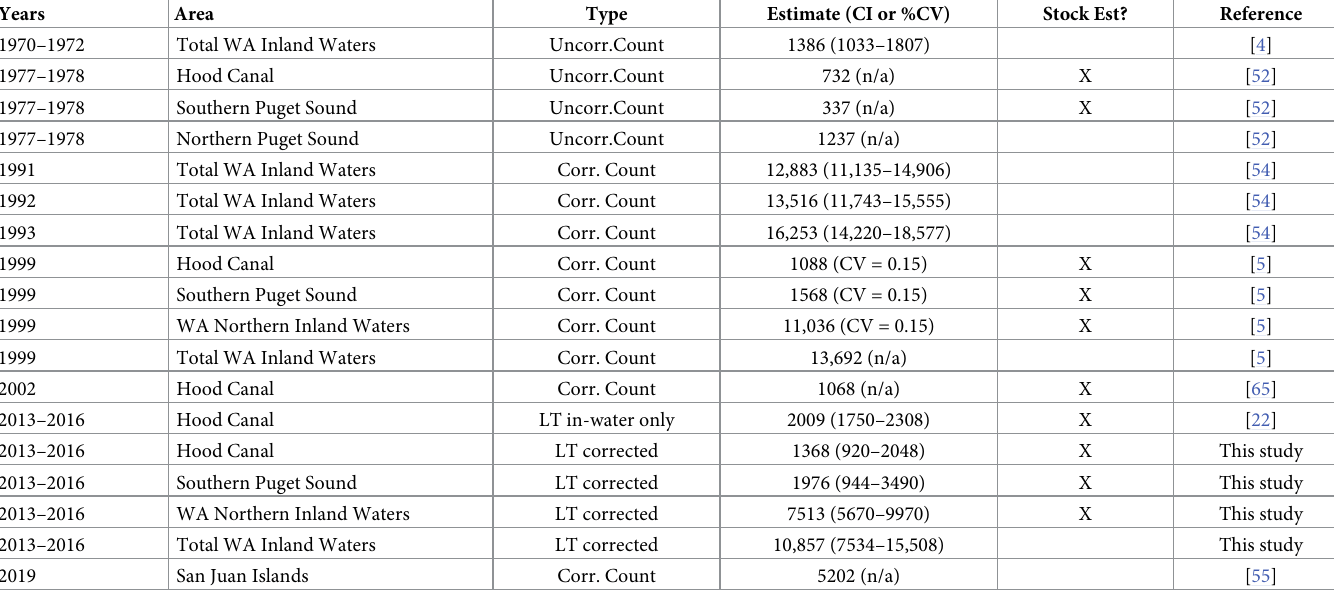
Table 6. Estimates of abundance and stock size for harbor seals in the inland waters of Washington.